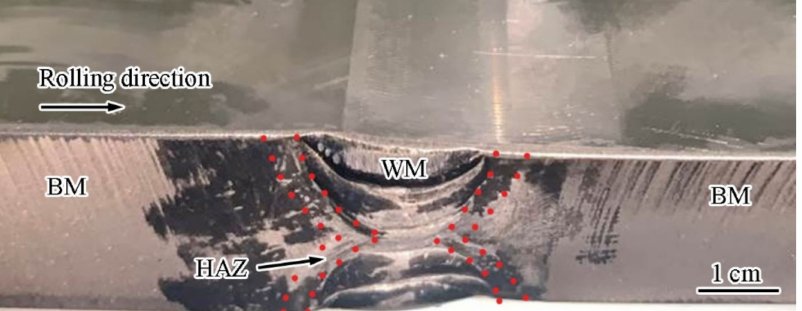
Figure 1. Ti6321 alloy GTAW